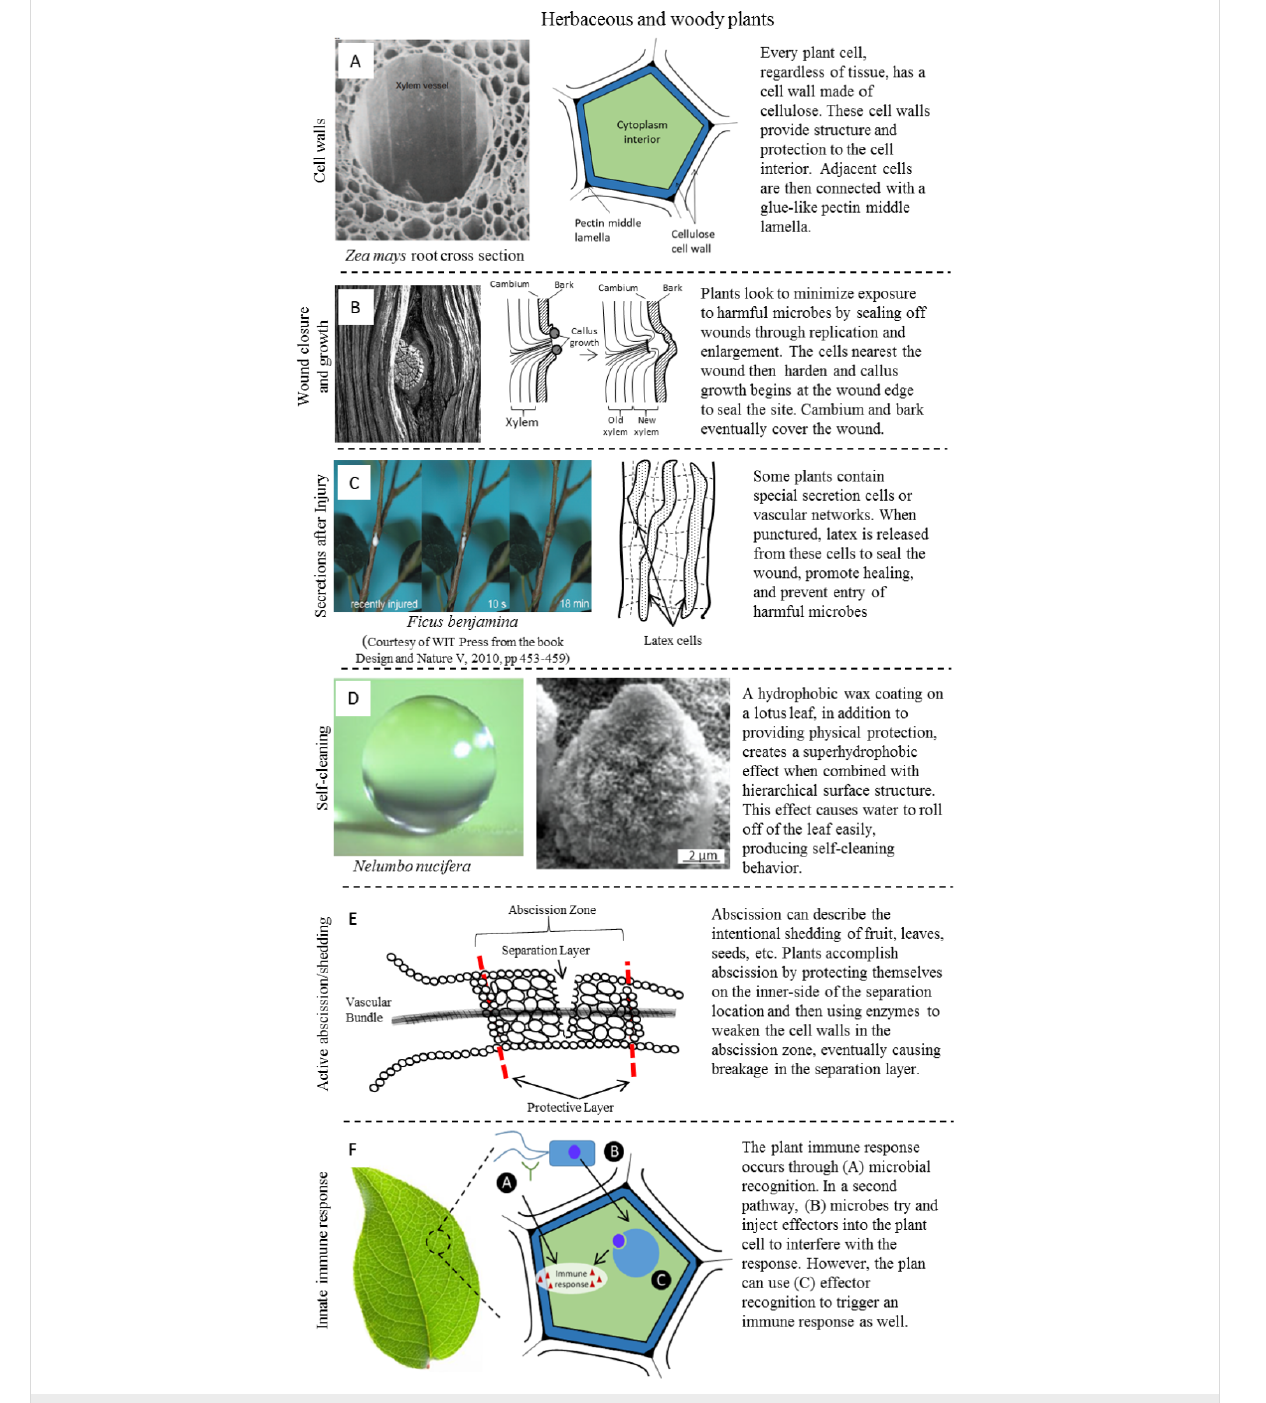
Figure 7: Healing and defense mechanisms in all plants (herbaceous and woody), including (A) protective cell walls, (B) wound closure and growth, (C) secretion cells, (D) functional layers, (E) abscission, and (F) immune response. (A) All plant cells are surrounded by a cell wall that (among other functions) protects the cell and provides structure. Left image reproduced with permission from [71], copyright 2005 Nature Publishing Group. (B) Cells at the surface of a wound in plants replicate and/or grow (hyperplasia and hypertrophy) to seal off the open wound and prevent disease. Left image reproduced from [72]. (C) Some plants have special secretion cells that release their contents to aid in healing and/or defense once the cell wall is damaged. Left image reproduced with permission from [73], copyright 2010 WIT Press. (D) Using a combination of hierarchical roughness and surface chemistry, plants can achieve complex self-cleaning behavior in surface (functional) layers. Images reproduced with permission from [32], copyright 2009 The Royal Society. (E) In order to purposefully release tissue such as damage leaves or seeds pods, plants use enzymes to break down tissue causing it to break more easily in a process called abscission. (F) Plant immunity relies on physical barriers in the cell wall and epidermis, but also uses an intracellular response to stave off harmful microbe